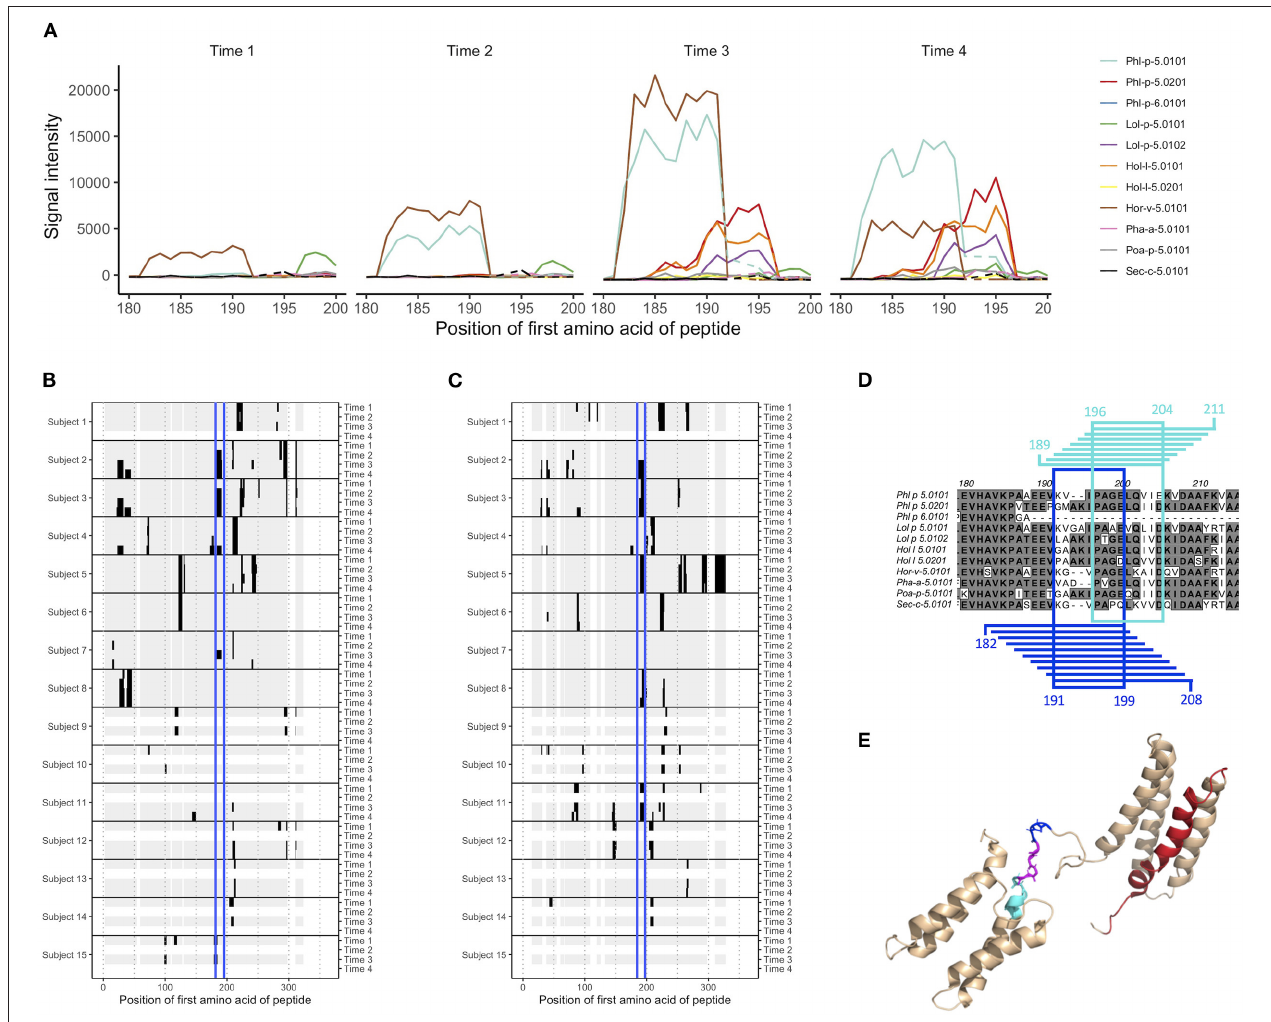
FIGURE 1 | Epitope B on group 5 and 6 grass pollen allergens stretches over linear peptides with their first amino acid in position 182–196, and can be further divided into epitope B1 and epitope B2. (A) IgG peptide-binding signal intensities with background subtracted (defined as mean for each sample and isotype) for subject 2, in the region covering epitope B. Signal intensity plots for other donors and isotypes are presented in Supplementary Figure 8 . Samples had been collected at AIT treatment initiation (time 1), and 8 weeks (time 2, when vaccine up-dosing had been reached), 1 year (time 3), and 3 years later (time 4). (B,C) Heatmap visualization of IgG recognition of linear epitopes on (B) Phl p 5.0101 and (C) Phl p 5.0201, with reactive peptides in black, non-reactive peptides in gray, and epitope B marked in blue. (D) Alignment of group 5 and 6 grass pollen allergens in the region covering epitope B. Peptides representing epitope B1 and their common amino acids are marked in blue, and peptides representing epitope B2 and their common amino acids are marked in cyan. (E) Solution structure (PDB id 2M64) of Phl p 5.0101 with epitope B1 (blue), B2 (cyan), their overlapping region (magenta), and epitope C (red)